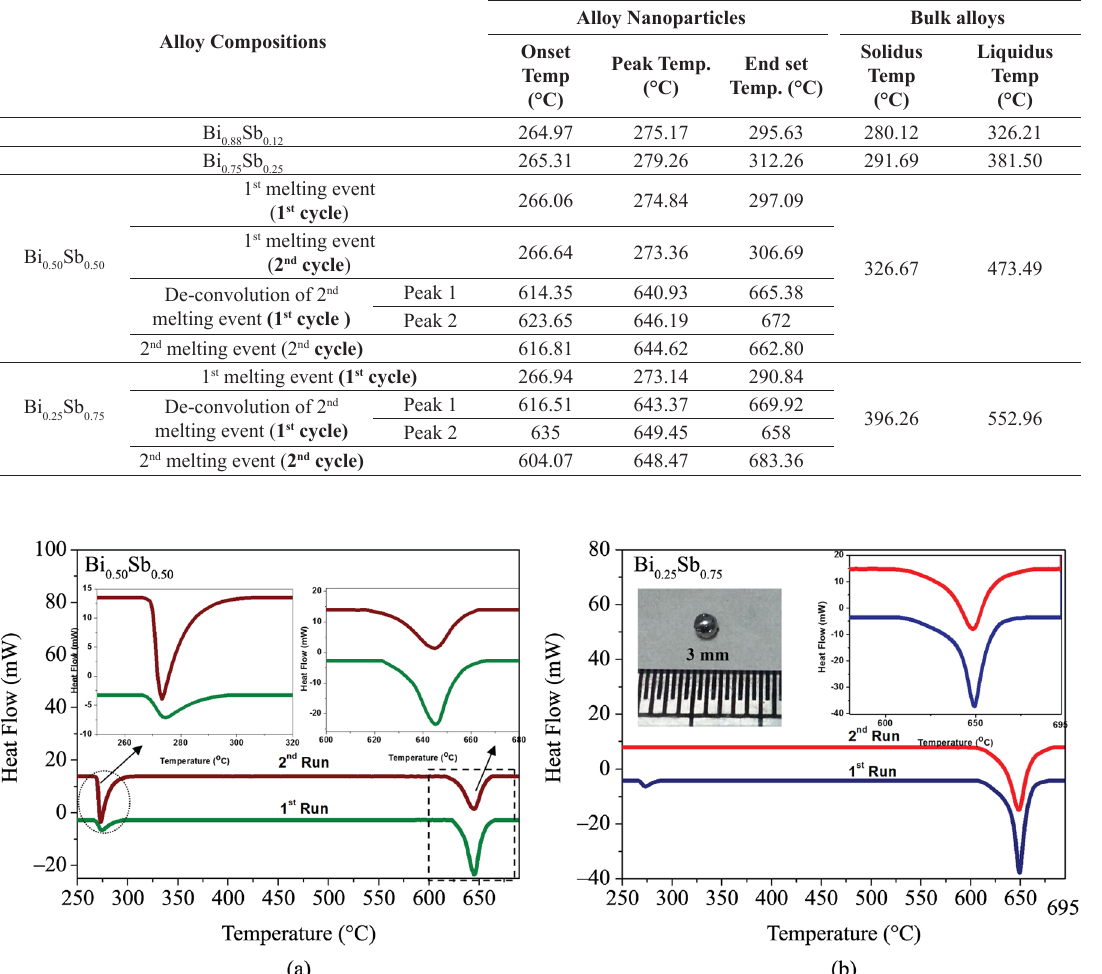
Sb alloys (x=0.12, 0.25, 0.50, and 0.75), prepared by solvothermal 1-x x as 1:0.5 with melting of corresponding bulk alloys of similar composition from 4